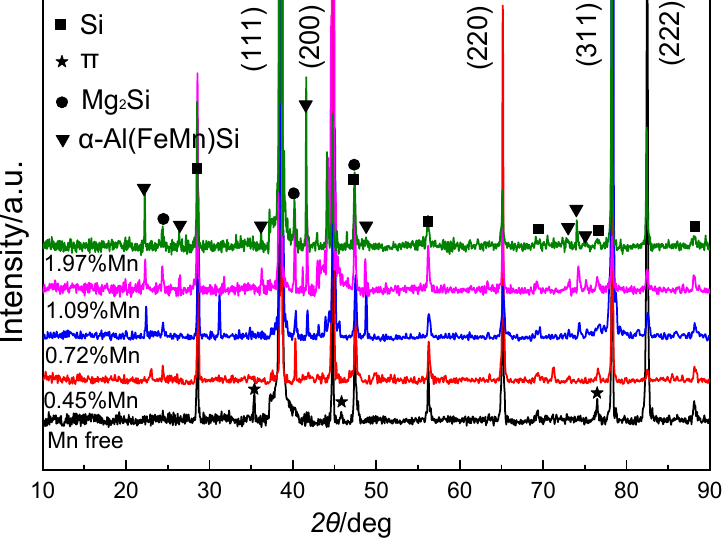
Figure 3. XRD patterns of Al-5Si-0.8Mg alloy ingots without Mn and those with 0.45% Mn,0.72% Mn, 1.09% Mn, and 1.97% Mn.